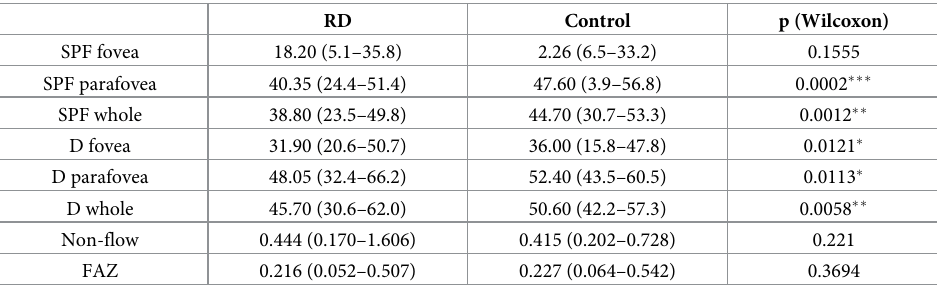
Table 3. Results of OCT-A measurements for all